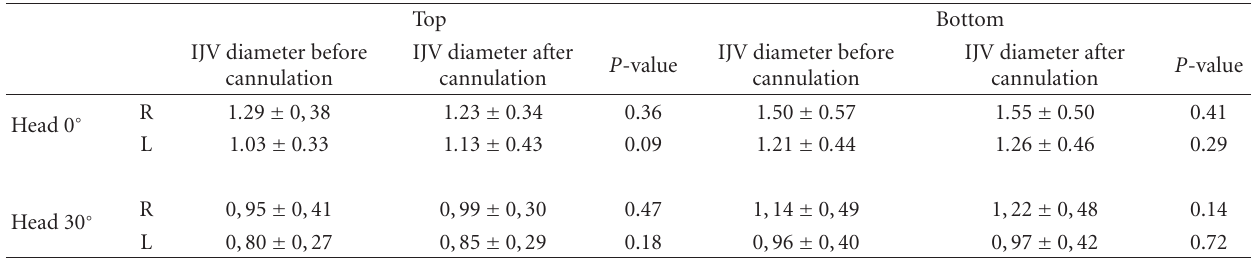
Table 2: Analysis of IJV cross-sectional diameters for each landmark point, with head in supine and head elevation at 30 ◦ (mean ± SD). Top Bottom IJV diameter after cannulation